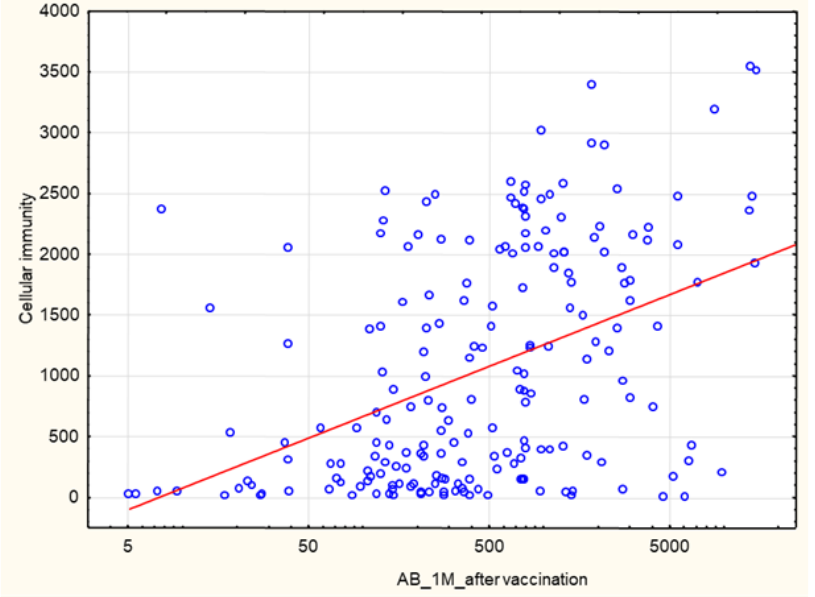
Figure 15. Positive correlation between AB levels (AU/mL) at 1 month after the 2nd dose of SARS- CoV- 2 vaccine and cellular immunity (INFγ concentration mIU/mL) at the same time ( p = 8.6 × 10 −11 , R 0.44). Spearman’s rank correlation test. A positive correlation was found between post-vaccination AB levels and the weekly hours on HD ( p = 0.017, R 0.14) (Figure 16). The correlation is statistically significant, although the strength of the relationship between the examined factors was weak.